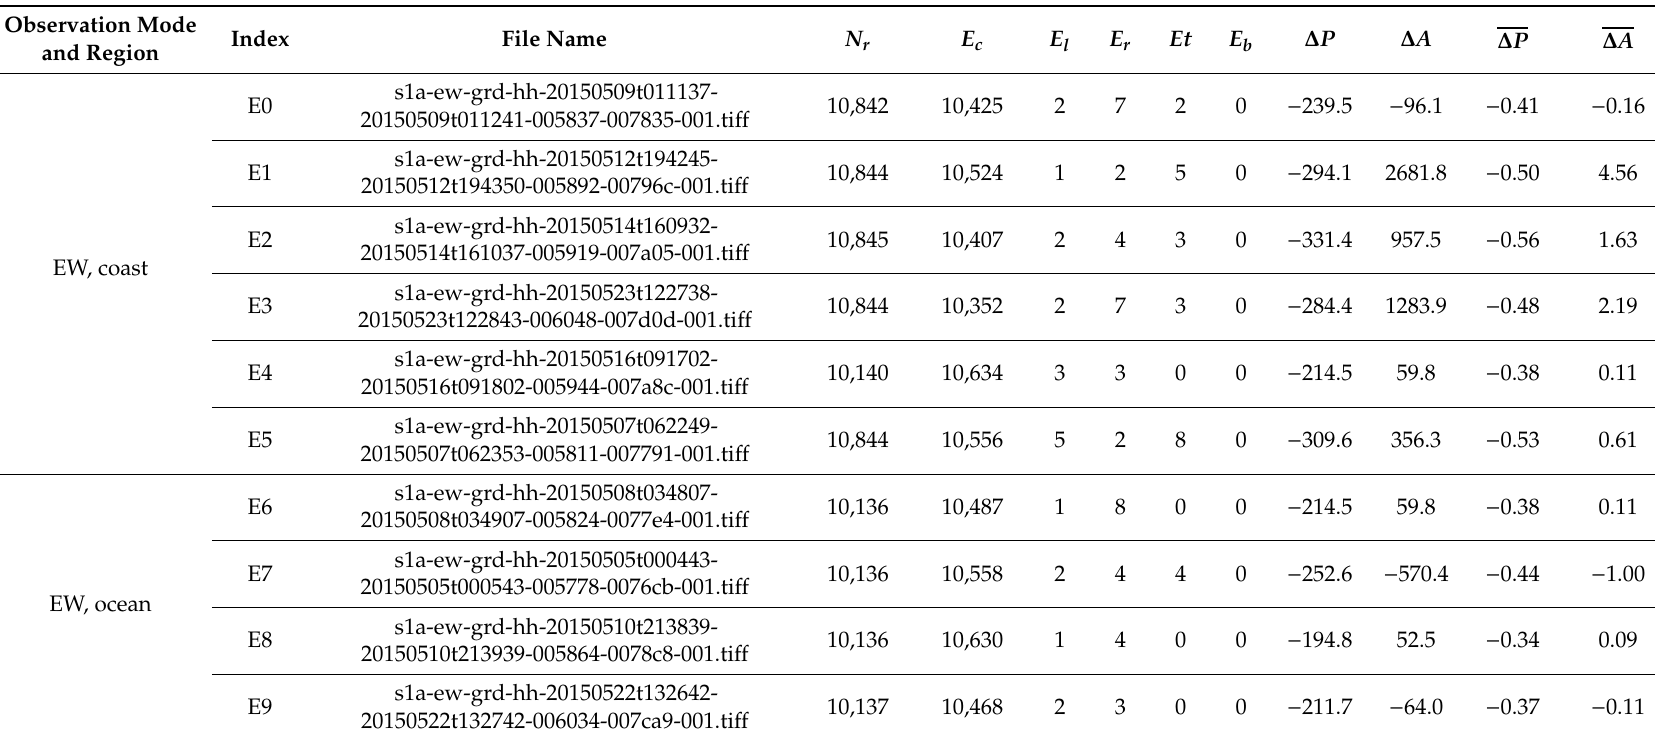
Table 1. Validation of the BM edge extracted from our method using human interpretation. ‘ N r ’ and ‘ N c ’ stand for the number of rows and columns of the image. ‘ E l ’, ‘ E r ’, ‘ E t ’, and ‘ E b ’ stand for the maximum extraction error of edge on the left, right, top, and bottom. ‘ ∆ P ’ and ‘ ∆ A ’ respectively stand for di ff erences in perimeter and area of e ff ective signal regions by subtracting automatic derivation results from human interpretation results. All of results are in unit of pixels. Observation